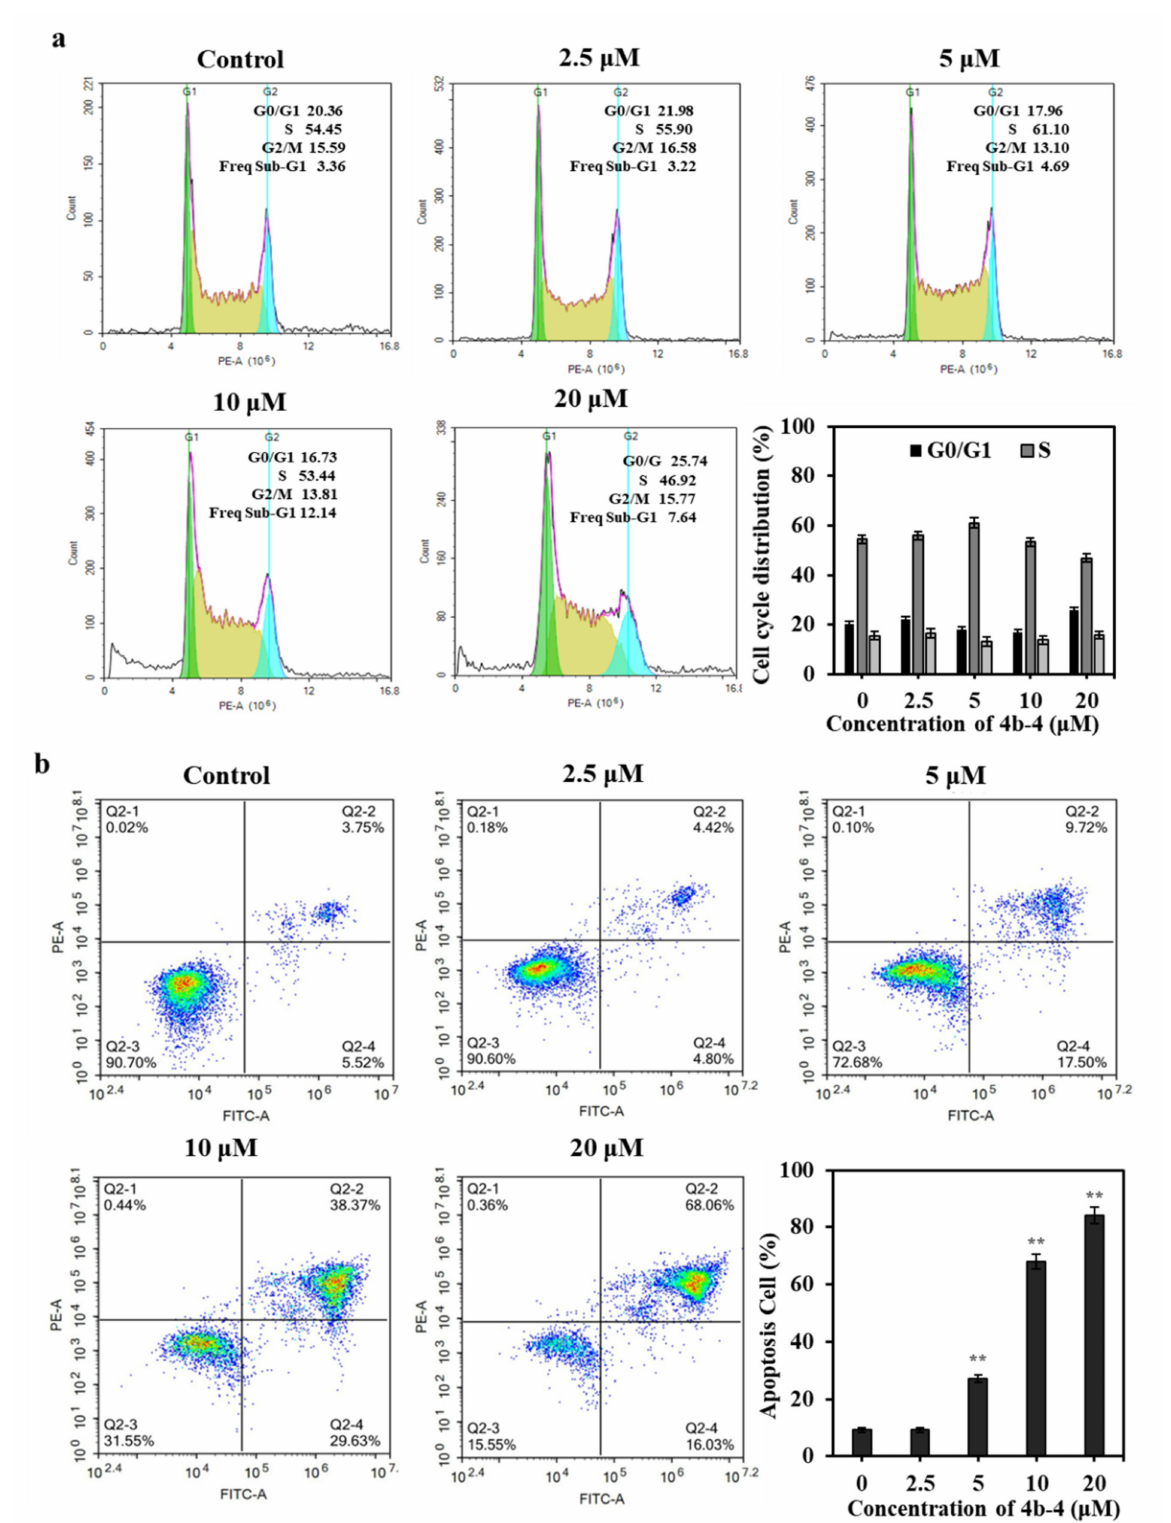
Figure 7. Assessment of apoptosis and cell cycle arrest in K562 cells treated with 4b-4. ( a ) K562 cells were treated with 4b-4 (2.5–20 µ M) for 24 h, and then cell cycle was analyzed by flow cytometer. The histogram shows the proportion of each cell cycle phase. ( b ) K562 cells were treated with 4b-4 (2.5–20 µ M) for 24 h, and then cell apoptosis was analyzed by flow cytometry. The histogram shows the percentage of apoptotic cells. Data are presented as mean ± SD for three independent experiments. ** p <